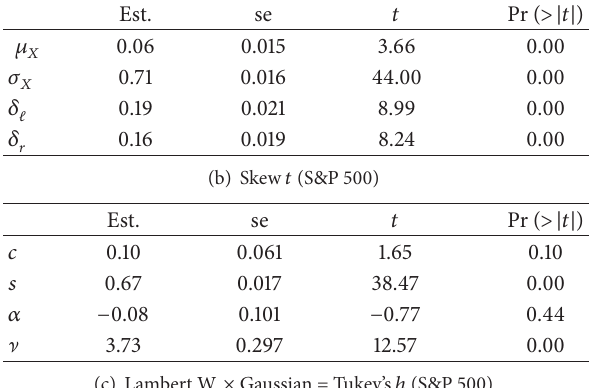
Table 4: MLE fits to S&P 500 y Tables 4(a), 4(b), 4(c), 4(d), and 4(e) and the Gaussianized data x ̂𝜏